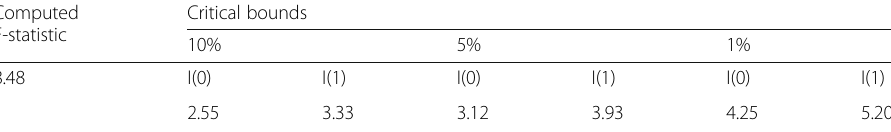
Table 5 Bound testing for co-integration analysis Computed F-statistic